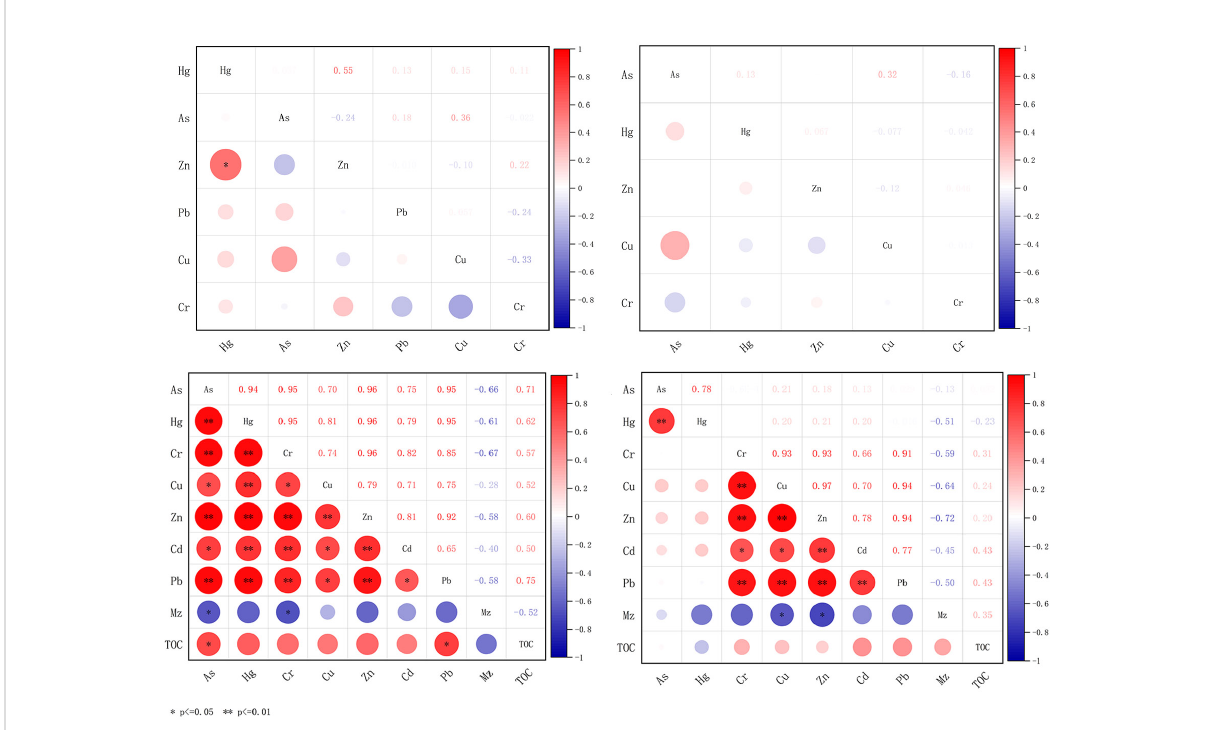
FIGURE 7 Correlation Analysis of Metal Elements in Seawater and Sediment of Daya